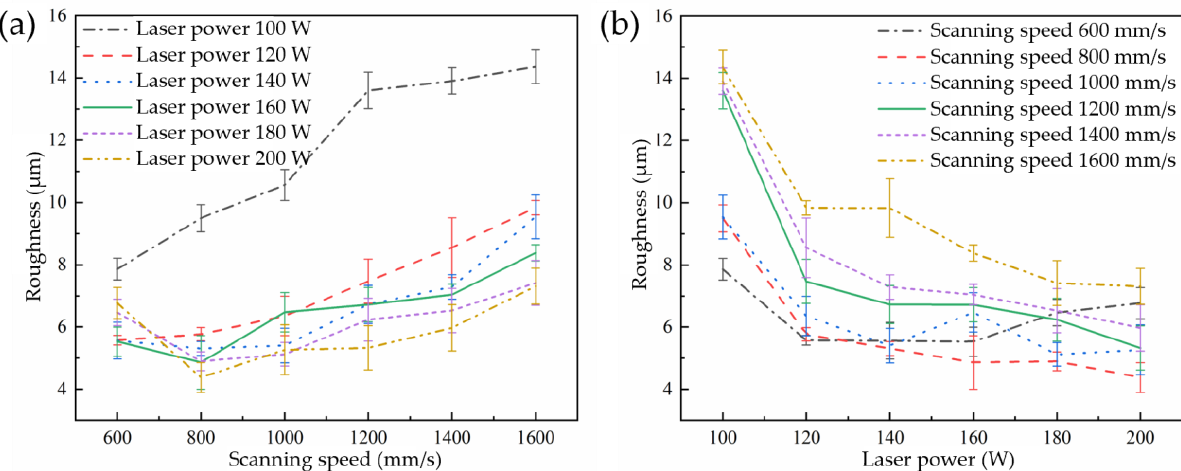
Figure 3. USR under different parameters: ( a ) scanning speed; ( b ) laser power.